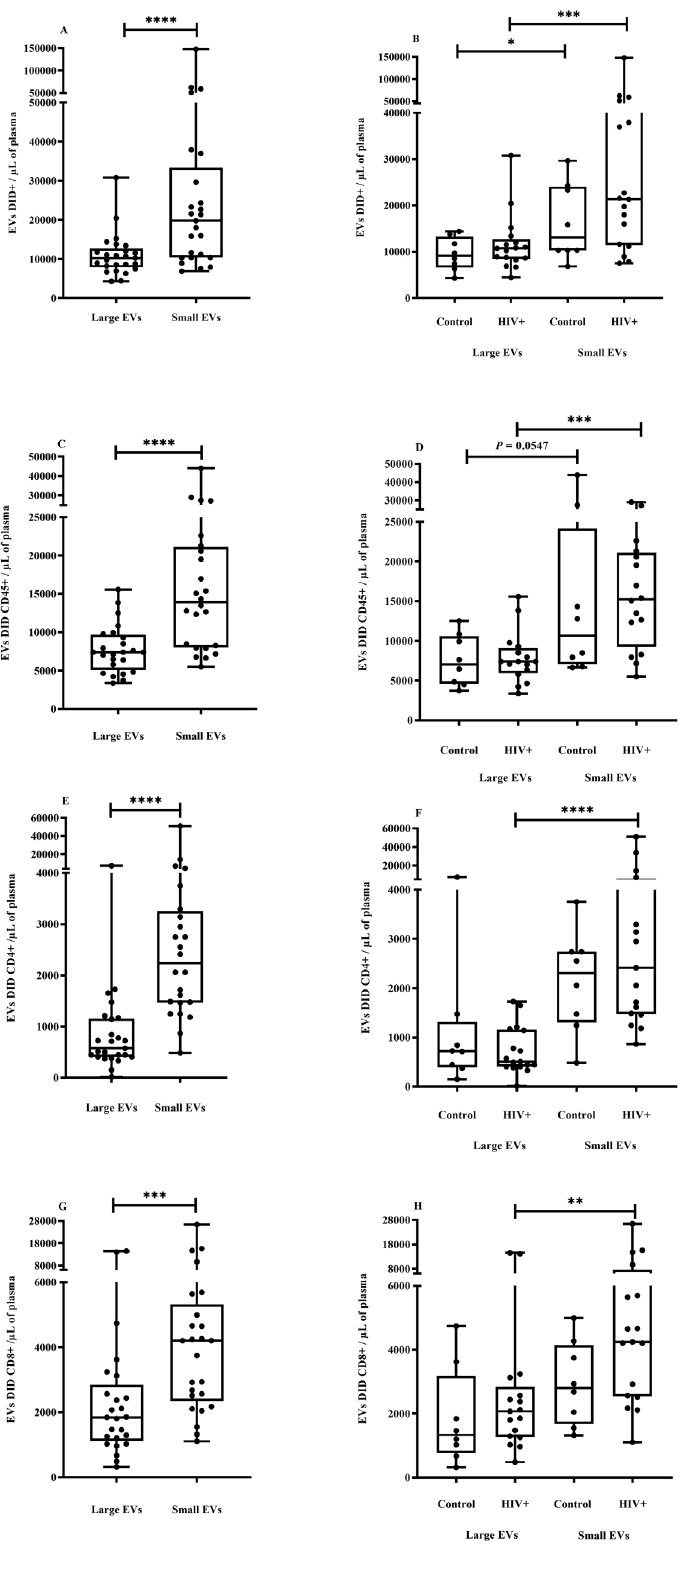
Figure 2. EV quantification and cell origin in association with HIV. Purified plasma EVs from uninfected (Control, n = 8) and HIV+ patients (n = 17) were stained with the lipophilic fluorescent tracer dye DiD to count total vesicles (Figure 2A and B), then labeled with antibodies directed against receptors CD45 (Figure 2C and D), CD4 (Figure 2E and F), and CD8 (Figure 2 G and H) to evaluate cell origin by cytofluorometry. Asterisks denote significant difference (** P ≤ 0.01; *** P ≤ 0.001; **** P ≤ 0.0001) based on Wilcoxon matched-pairs signed-rank test or Mann-Whitney